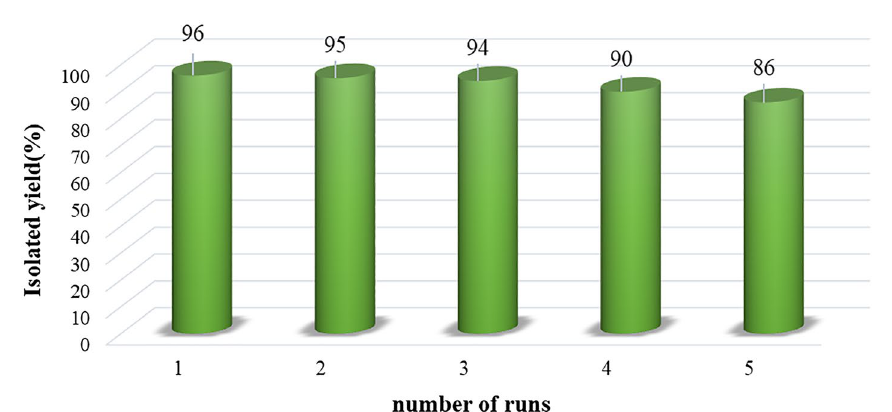
Figure 9. Reusability of the multifunctional heterogeneous Cs-EDTA-Cell network ( 1 ) in five consecutive runs for the synthesis of 5a